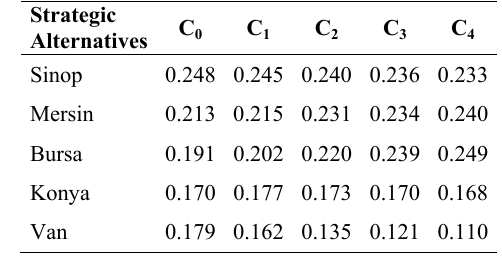
Table 10 – Closeness coefficients of the strategic alternatives with respect to the considered cases